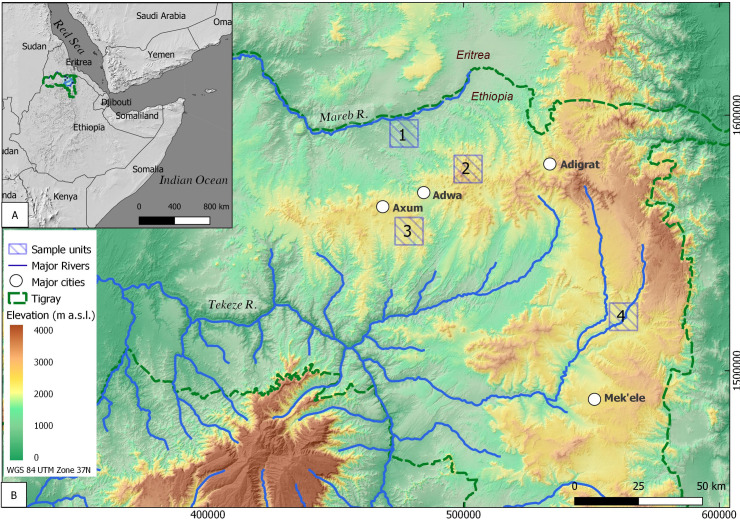
A: The Horn of Africa with the Tigray region of the Ethiopian Highlands marked in dash green line. B: The study area in central eastern Tigray. Numbered squares correspond to 10x10 km sample units: 1. Rama, 2. Yeha, 3. Daragà and 4. Wuqro. Sources: A: Natural Earth open source data available at naturalearthdata.com. B: color-coded hillshade map based on 30 m SRTM DEM provided by USGS earth explorer [81–83].